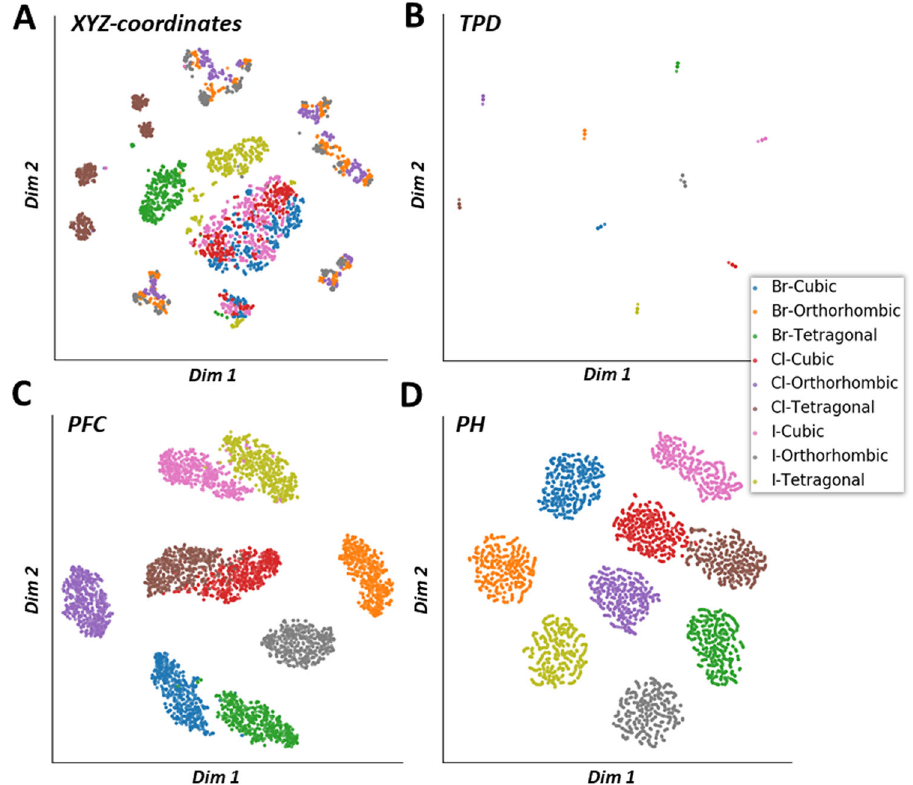
Fig. 3 The clustering of 9 types of OIHP molecular dynamics (MD) trajectories. Four feature generation schemes are considered, including XYZ-coordinates ( A ), traditional perovskite descriptors (TPD) ( B ), persistent Forman curvature (PFC)-based fi ngerprint ( C ), and persistent homology (PH)-based fi ngerprint ( D ). Each trajectory contains 1000 con fi gurations and t-SNE model is used for clustering (of the last 500 con fi gurations at equilibrium). The x-axis and y-axis are the two principal dimensions in the t-SNE